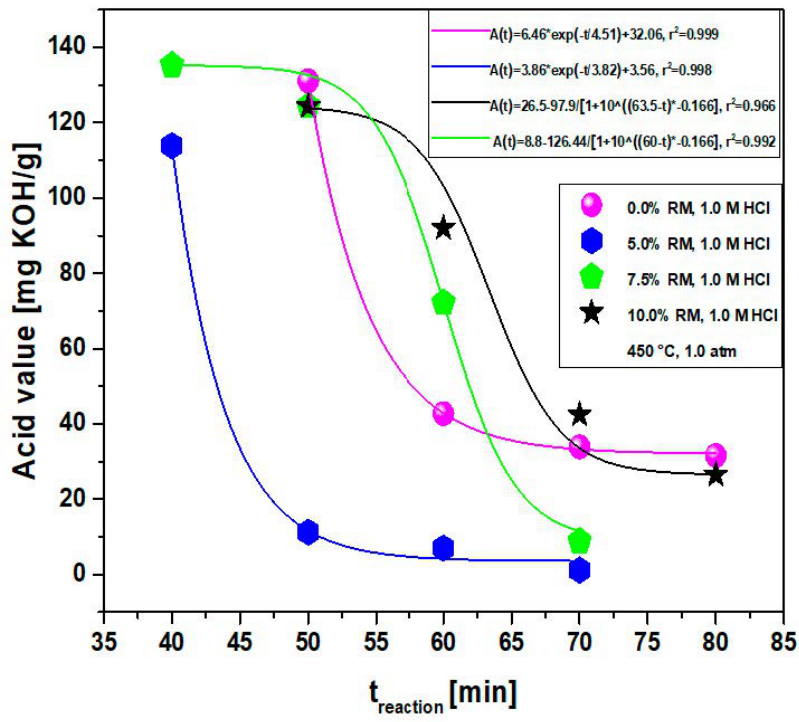
Figure 15. Effect of reaction time on the acidity of bio-oil by the upgrading of residual fat pyrolysis vapors at 450 °C, 1.0 atmosphere, 0.0, 5.0, 7.5, and 10.0% (wt.) of red mud pellets activated with 1.0